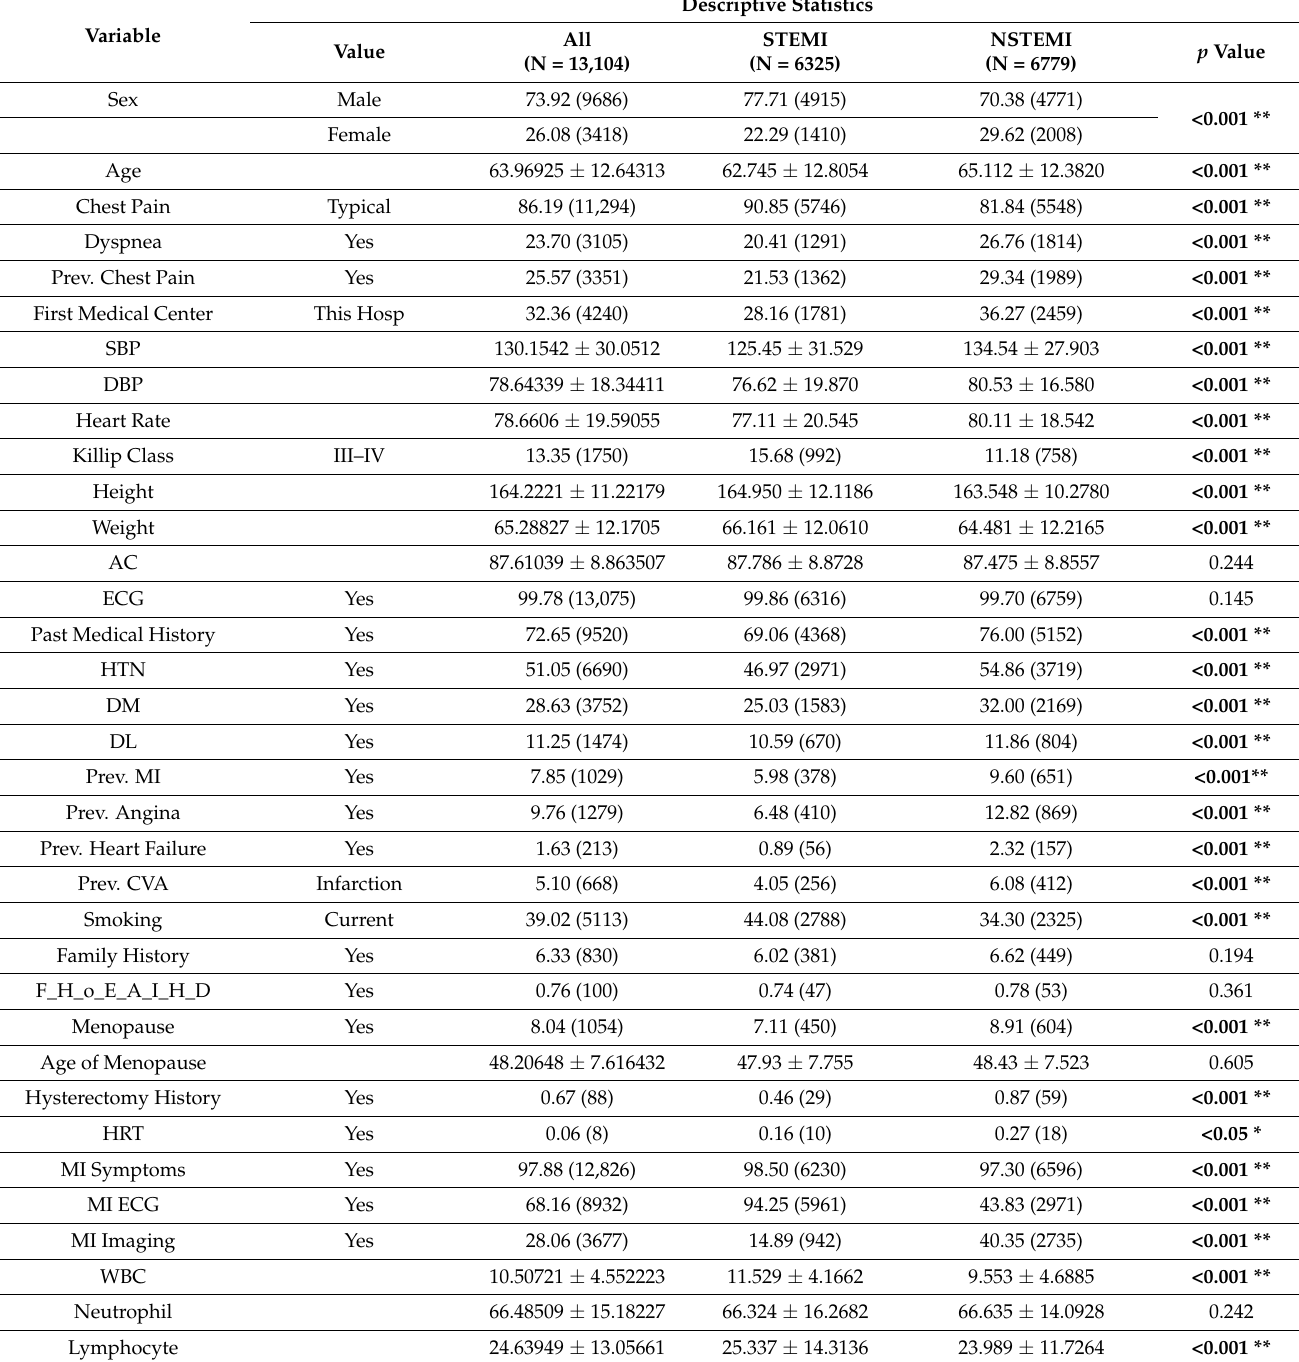
Table A1. Baseline characteristics of all applied features for all subjects (N =